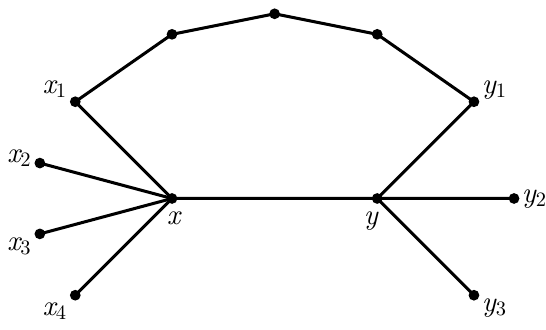
Figure 3 . Part of a graph which may qualify as \almost a tree." The important criterion is that the alternate route from x 1 to y 1 , passing through the top four edges, must be longer than the path from x 1 to y 1 through the edge xy